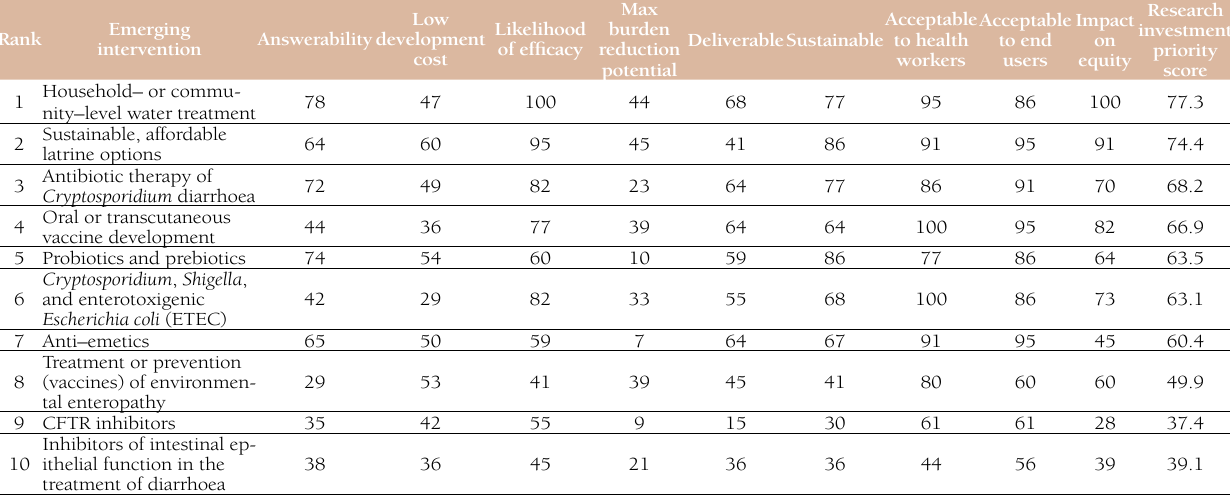
Table 3. The results of the CHNRI exercise: 10 emerging interventions with 9 intermediate scores and an overall research priority